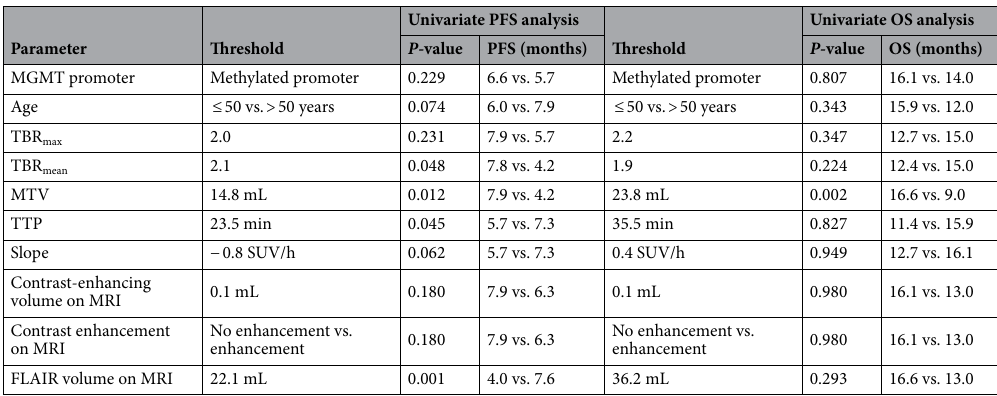
Table 3. Results of univariate survival analyses regarding general prognostic factors, FET PET, and MR imaging parameters. FLAIR fluid attenuated inversion recovery, MGMT O 6 -methylguanine-DNA methyltransferase, MTV metabolic tumor volume, OS overall survival, PFS progression-free survival, slope = slope of tracer uptake 20–50 min post-injection , TBR max maximum tumor-to-brain ratio , TBR mean mean tumor-to-brain ratio, TTP